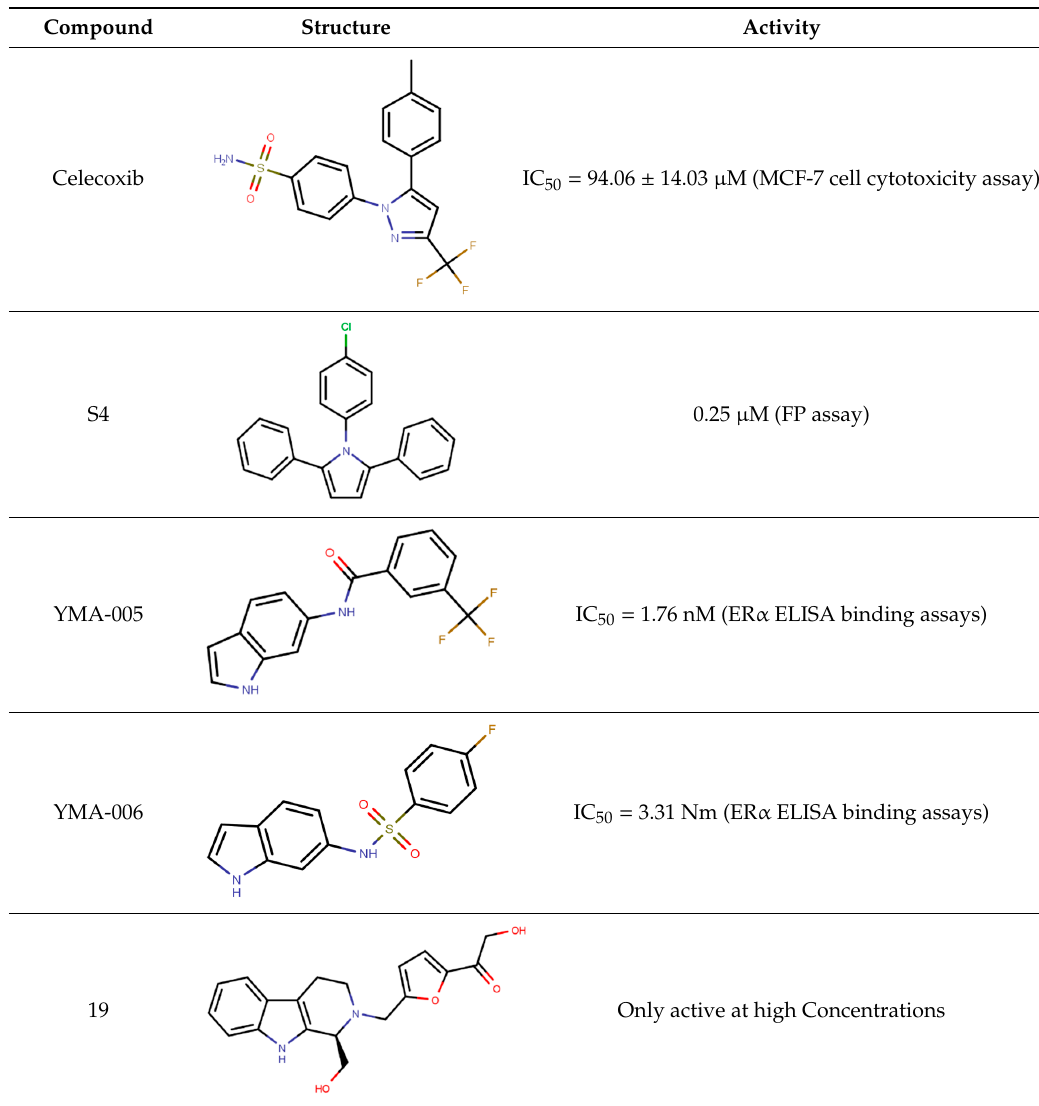
Table 2. ER ligands validated with CADD.